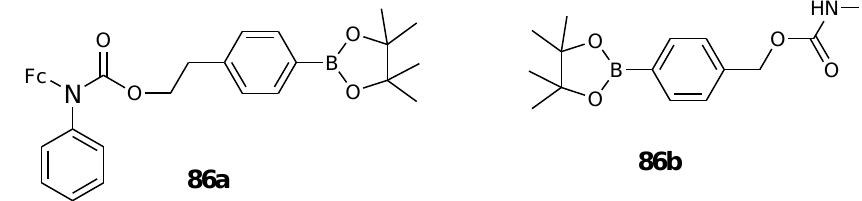
Figure 33. Chemical structure of aminoferrocene-based derivatives ( 86a – b ).